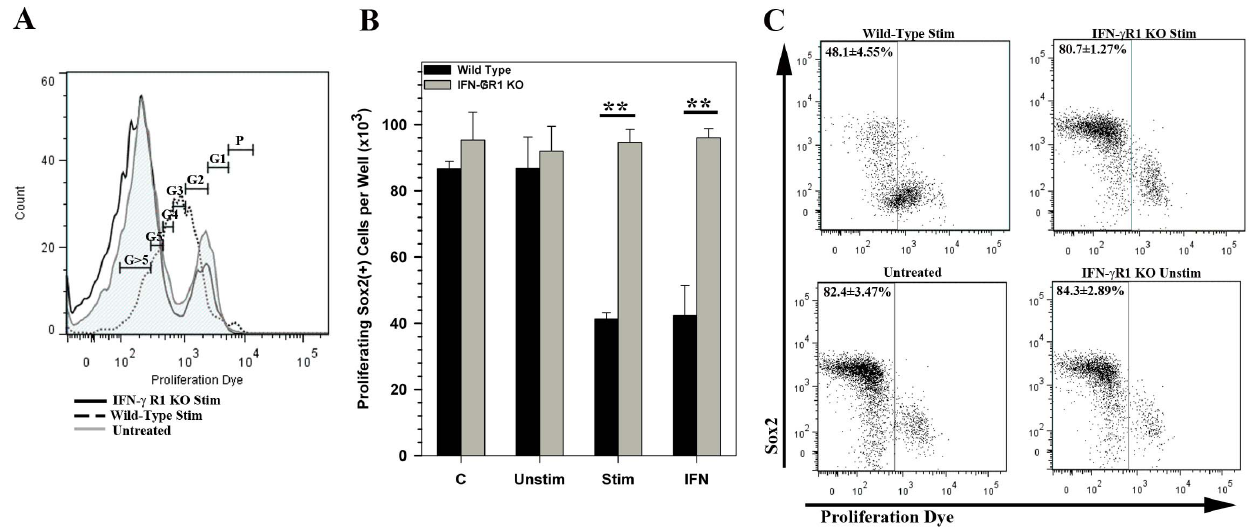
Figure 5. IFN- c R1 knockout NSCs are resistant to CD8 T-cell mediated inhibition of proliferation. NSCs were labeled with eFluor670 proliferation dye and were cultured alone (untreated), with 20 pg/mL IFN- c (IFN) or in the presence of unstimulated (Unstim) or stimulated CD8 T cells (Stim). (A) Representative flow histograms of stimulated CD8 T cell treated and untreated NSCs demonstrating dilution of labeling dye fluorescence corresponding to cell divisions. Gates for generation of progeny was allocated based on progressive halving of the fluorescence measured in dividing NSCs (calculated using a cell proliferation algorithm in the FlowJo software). Proliferation of IFN- c R1 KO NSCs when co-cultured with stimulated CD8 T-cells (black line) compared to untreated NSCs (untreated, gray tinted line), or wild-type NSCs cultured with stimulated CD8 T- cells (dotted line) is shown. (B) Quantification of total number of proliferating Sox2( + ) NSCs in shown under each culture condition for wild type and IFN- c R1 KO NSCs. Data are presented as an average of three replicates 6 SEM. ** p , 0.01. (C) Representative dot plots showing Sox2 immunolabeling vs dilution of proliferation dye fluorescence observed in wild type (upper left) and IFN-GR1 KO NSCs (upper right) co-cultured with stimulated CD8 T- cells. Untreated NSC cultures (lower left) and those co-cultured with unstimulated CD8 T-cells (lower right) show no difference in proliferation or Sox2 expression. Gates are drawn to indicate cells that have undergone five to seven rounds of division (or proliferation dye dilution) post culture and the percentages of proliferating cells are presented as average 6 SEM.